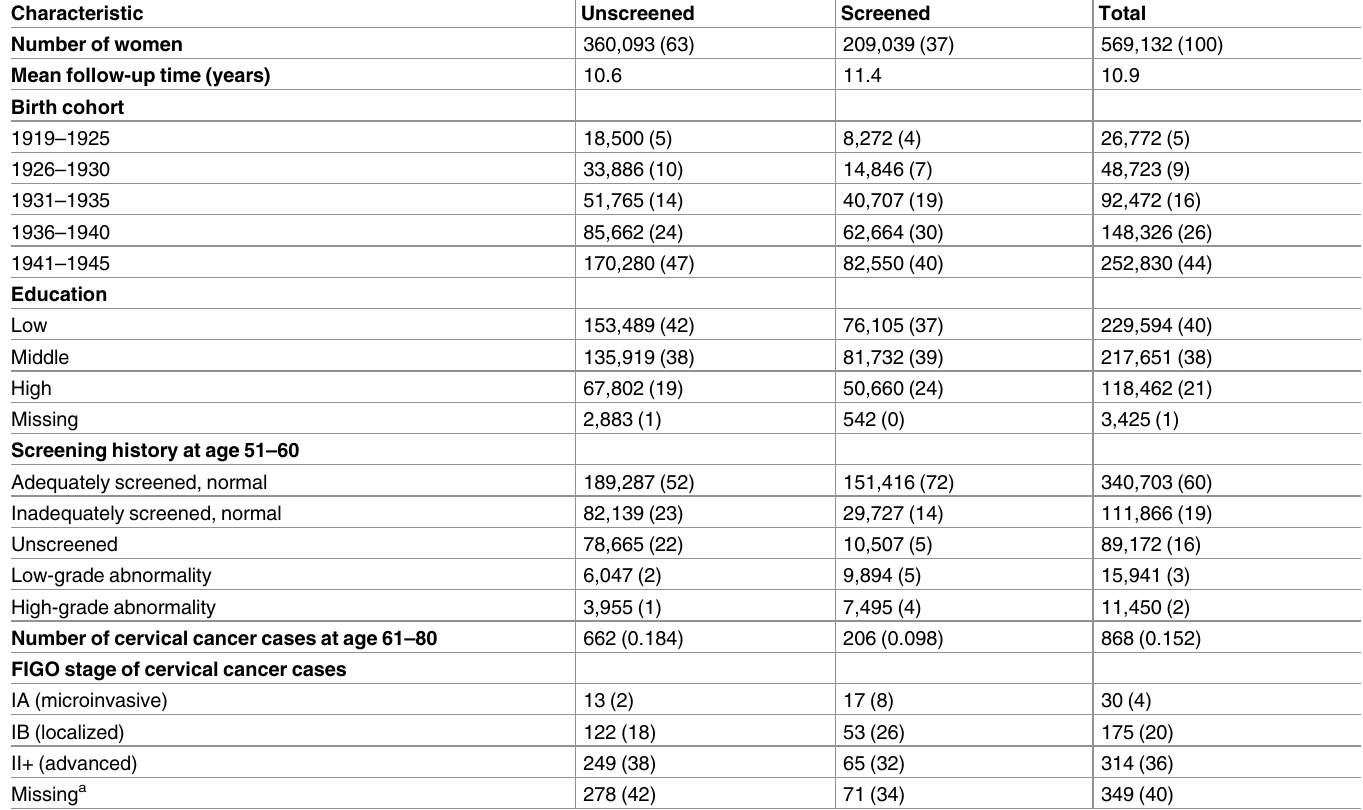
Table 1. Characteristics of the study population, by cervicalscreening status at age 61–65 years. Characteristic